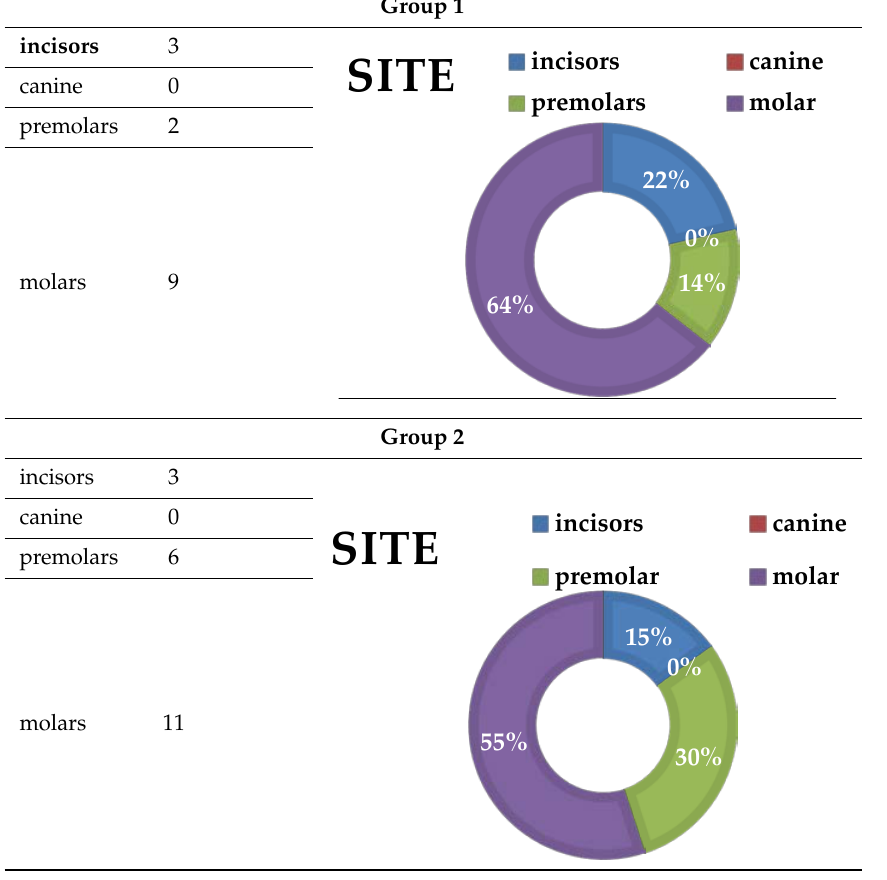
Table 3. Tooth analysis type and site.